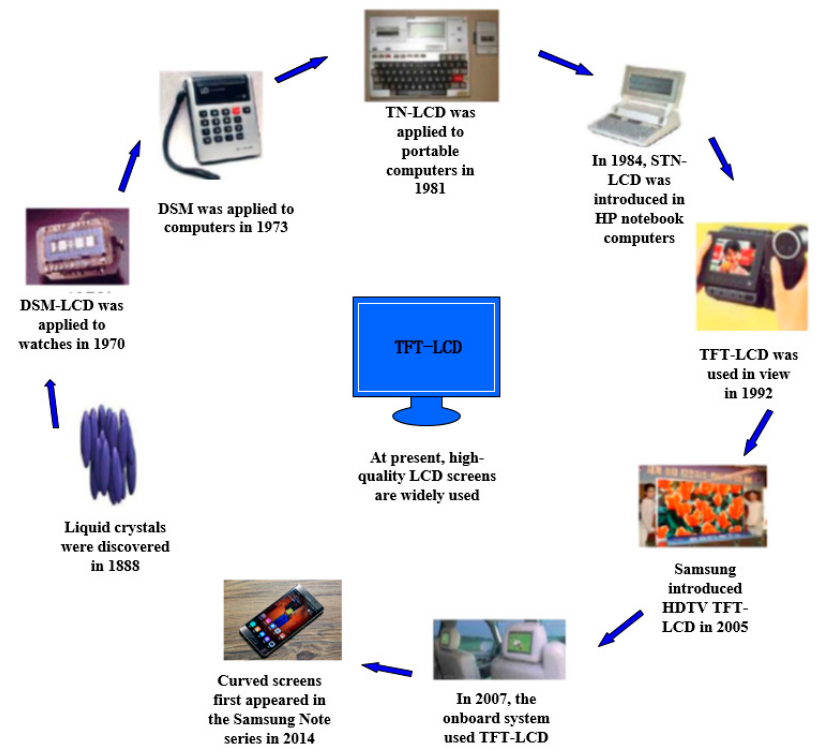
Figure 1. Development process of liquid crystal display technology, from the earliest principle to the current universal application.